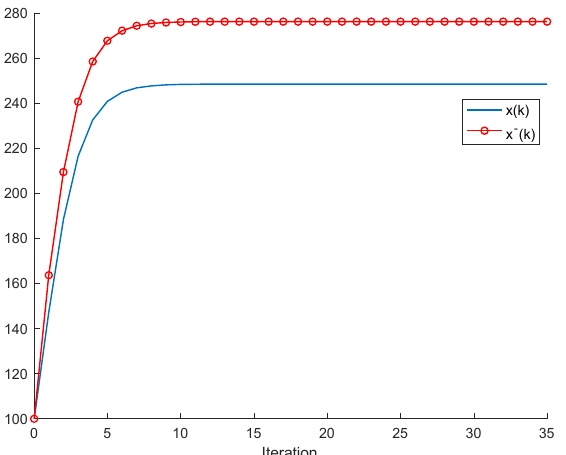
Figure 3. Evolution of x ( k ) for constant parameters in Example 3, including harvesting and external consumption. The population converges to a positive equilibrium point.